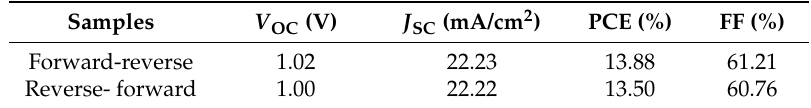
Table 2. Summarized photovoltaic parameters of PSC devices scanned form forward voltage to reverse voltage and scanned form reverse voltage to forward